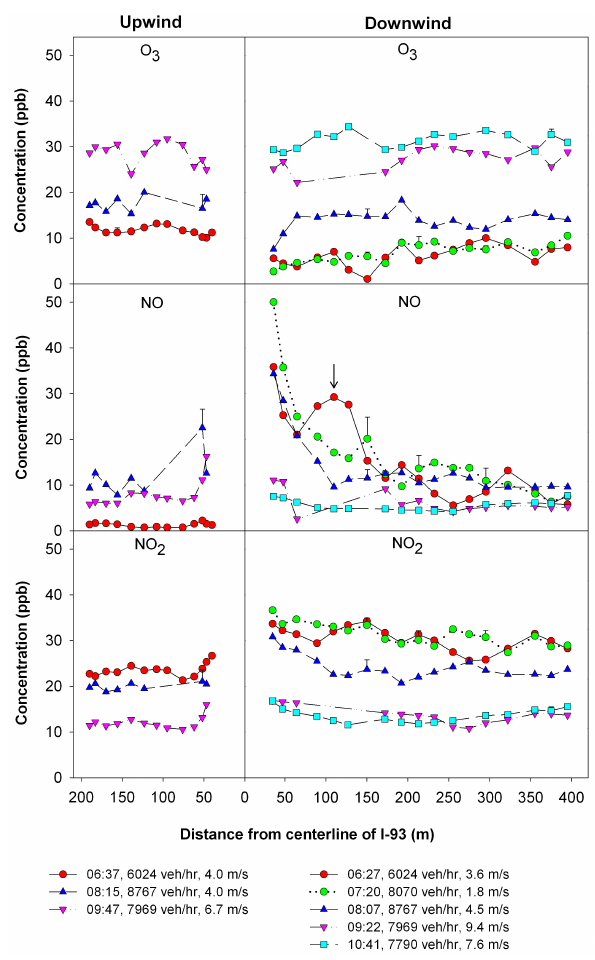
Fig. 6. Spatial and temporal variation of O 3 , NO, and NO 2 along transects perpendicular to I-93. Legend shows vehicles per hour on I-93 (both directions) and average hourly wind speed. Error bars (one SD) are shown at locations where the AML stopped briefly and multiple measurements were made. Spike in 06:27 NO profile (indicated with arrow) likely represents the plume from a vehicle passing nearby the AML; spikes immediately upwind of the high- way were likely due to traffic on Rt.